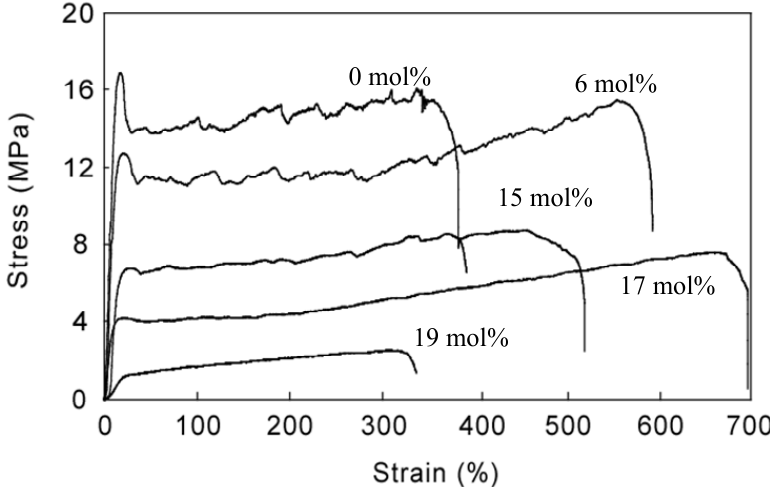
Figure 8. Stress-strain curves of PHS/M-6 with various HM-6